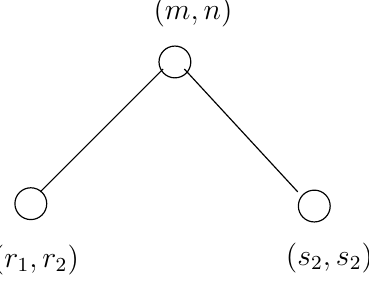
Figure 3: Unique labeled-tree representation of the unique JL -coloring of K the tree can be relabeled to represent JL -colorings of K To accomplish this, change k (cid:0) 1 of the leaf labels (0 ; 1) (leaving the bottom such leaf alone) to (1 ;